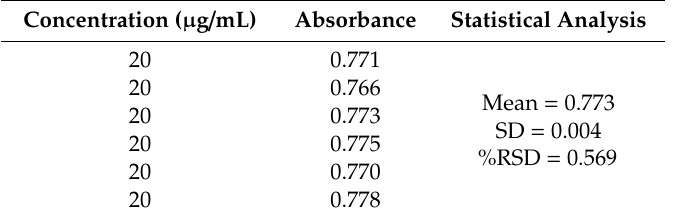
Table 7. Statistical validation for repeatability studies using UV-vis spectrophotometer.